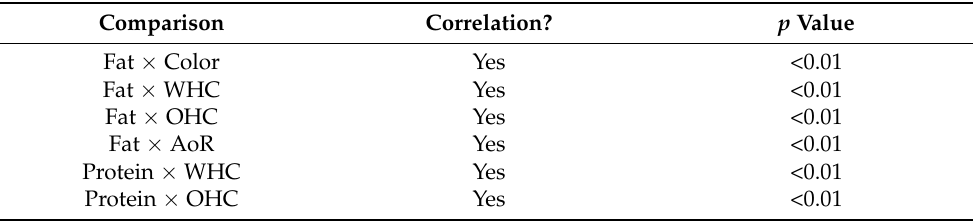
Table 4. Correlation between the powder composition and powder